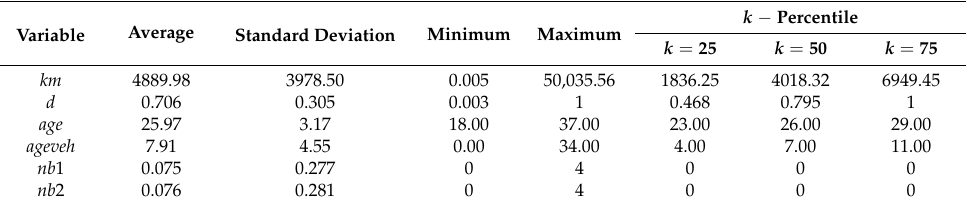
Table 1. Descriptive statistics for variables km , d , age , ageveh , nb 1 and nb 2.